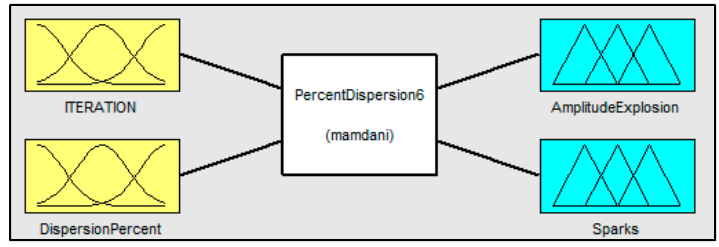
Figure 9. Graphical representation of the Fuzzy System for DPIFFWA-II.